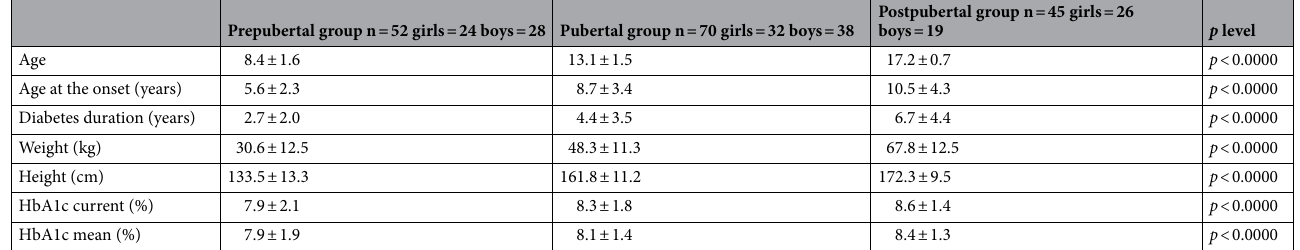
Table 2. Characteristic of the groups regarding pubertal status. HbA1c glycated haemoglobin.